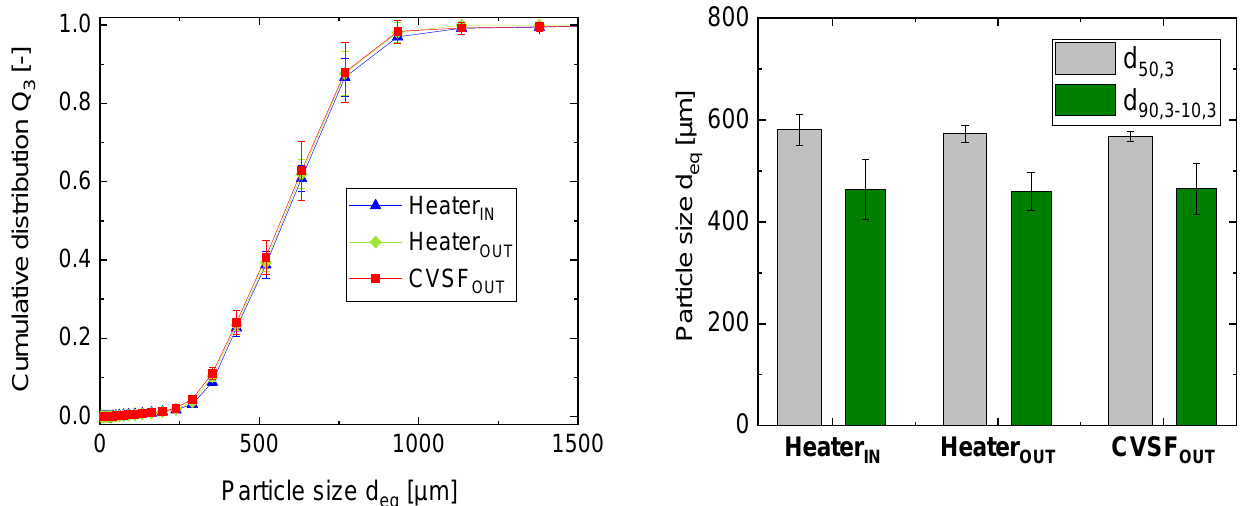
Figure 3. Preliminary experiments (averaged results from four experiments) regarding the heating section using a defined undersaturation: Averaged volume-based PSDs ( left ) and their characteristic values d 50,3 and d 90,3-10,3 ( right ) at the corresponding sections; Experimental conditions: ϑ heater , PM , IN = 23 ◦ C (saturated suspension), ϑ heater , PM , OUT = 30 ◦ C (undersaturated), Q susp = 60 mL min − 1 , w s = 6 wt.%, n screw = 3